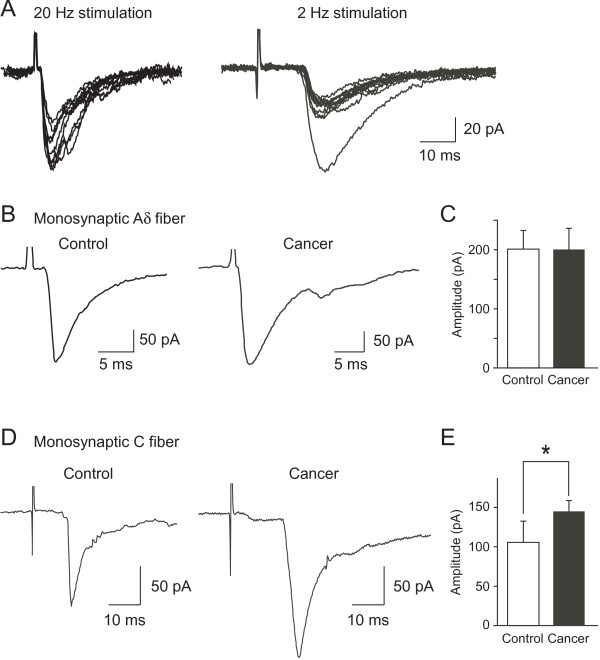
Monosynaptic afferent fiber-evoked EPSCs in SG neurons of control and cancer-bearing mice. Monosynaptic Aδ and C fiber-evoked EPSCs in response to the stimulation of dorsal root attached to the spinal cord slices (A). The monosynaptic nature was clarified based on their constant latencies and absence of failures with repetitive stimulations (20 Hz and 2 Hz for Aδ and C fiber's responses, respectively; see Methods). Representative averaged traces of monosynaptic Aδ fiber-evoked EPSCs in control (left) and cancer-bearing (right) mice (B). There was no significant difference in the amplitude of monosynaptic Aδ fiber-evoked EPSCs between control (n = 13) and cancer-bearing (n = 14) mice (right) (C). Representative averaged traces of C fiber-evoked EPSCs in control (left) and cancer-bearing (right) mice (D). The amplitude of monosynaptic C fiber-evoked EPSCs was significantly increased in cancer-bearing (n = 12) than control mice (n = 10), P < 0.05 (Mann-Whitney U-test) (E). Values represent means ± S.E.M.